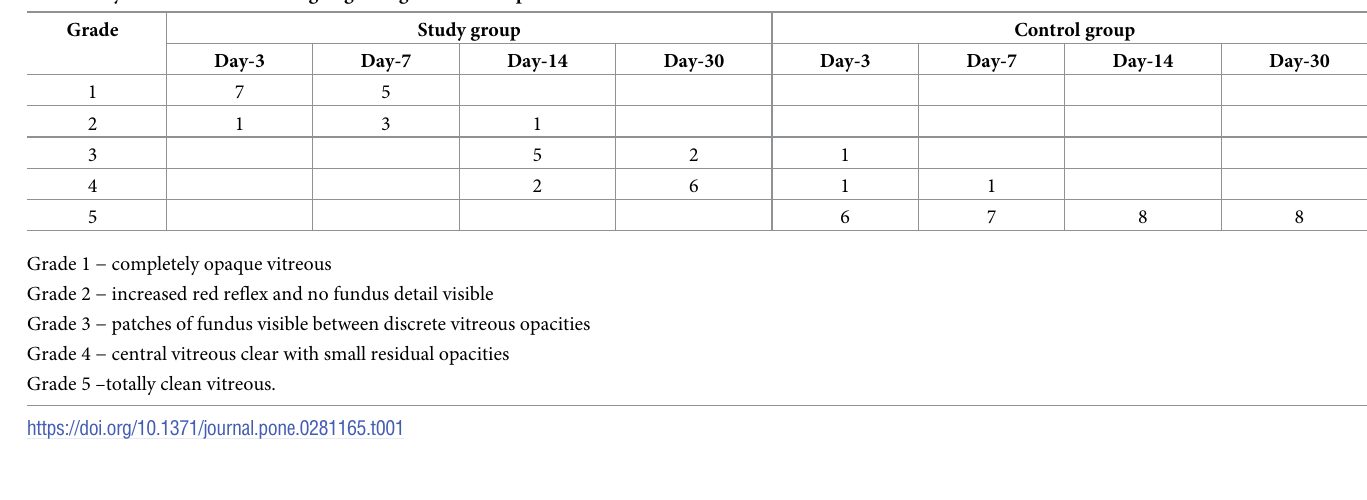
Table 1. Eyeball number according to grading of vitreous